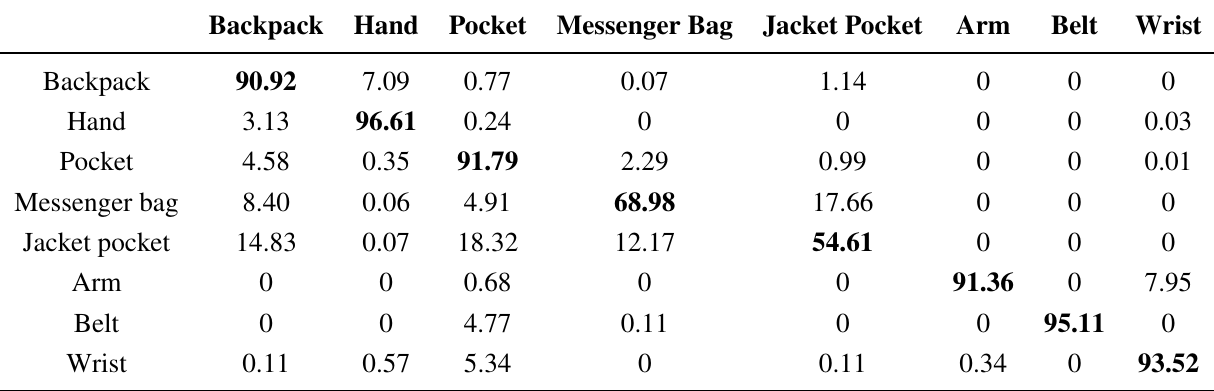
Table 13. Confusion matrices with the walking activity, random forest, in %. Backpack Hand Pocket Messenger Bag Jacket Pocket Belt